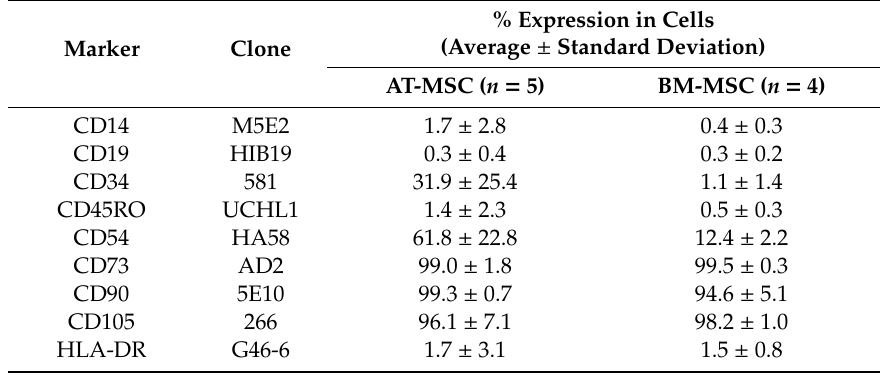
Table 1. Characterization of AT-MSCs and BM-MSCs by surface marker expression with flow cytometry analysis. Clone information for marker antibodies is also provided. % Expression in Cells (Average ± Standard Deviation) Marker Clone AT-MSC ( n = 5) BM-MSC ( n = 4) CD14 M5E2 1.7 ±